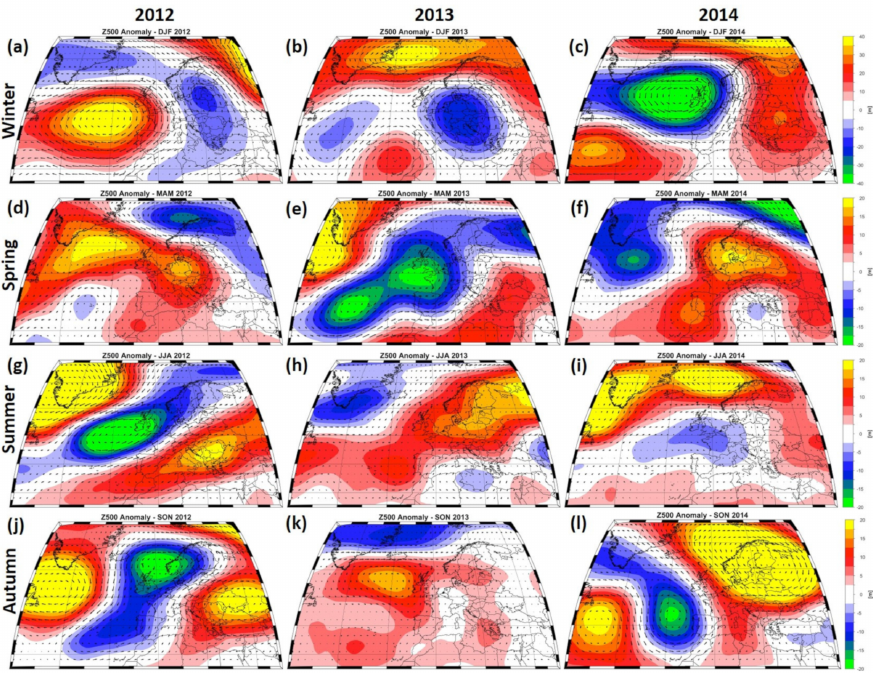
Figure 8. The seasonal geopotential height at 500 mb (Z500) anomalies over the period of January 2012 to December 2014. The anomalies are computed relative to the climatological period 1971–2000. Units: